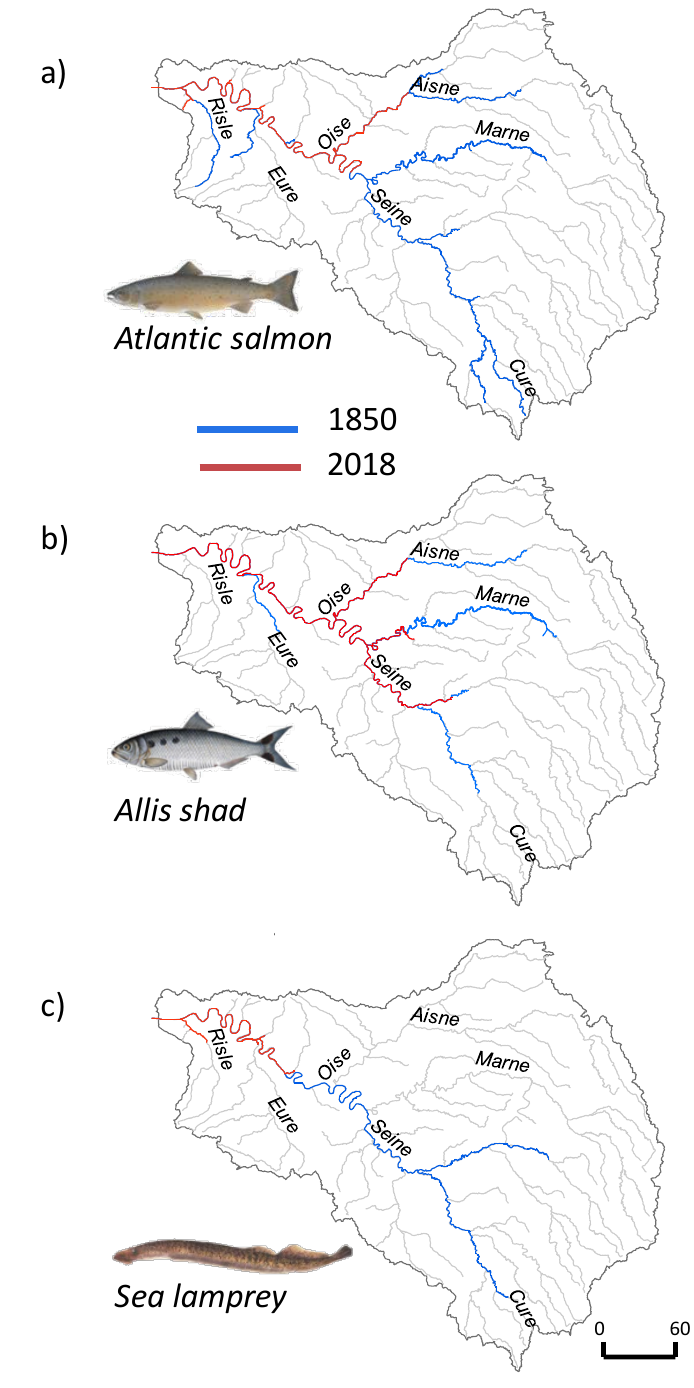
Figure 6. Historical distribution in 1850 overlaid by current distribution in 2018 for Atlantic salmon ( a ), allis shad ( b ) and sea lamprey ( c ) on the Seine River Basin. No distribution was drawn for 1970, as all these three species were regarded as extirpated at that